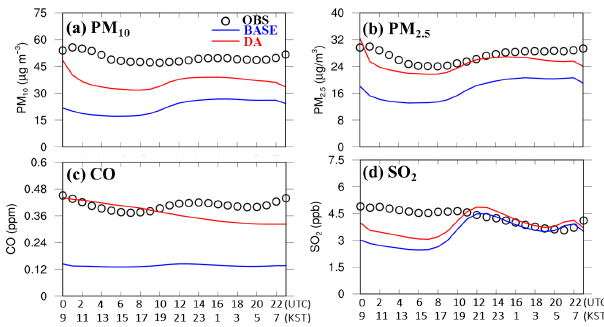
Figure 6. Aggregated average concentrations of (a) PM 10 , (b) PM 2 . 5 , (c) CO and (d) SO 2 at 264 Air Korea stations over the KORUS-AQ campaign period. Open black circles denote the ob- servations obtained from 264 Air Korea stations in South Korea. Blue and red lines represent the predicted concentrations from the BASE RUN and DA RUN, respectively. The DA was conducted at 00:00UTC every day throughout the KORUS-AQ campaign period.